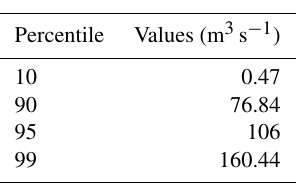
Figure 3. Kendall coefficient of high flow (a) and Low Flow (b) Variables. Table 2. Percentile calculated from 1956 to 1985.